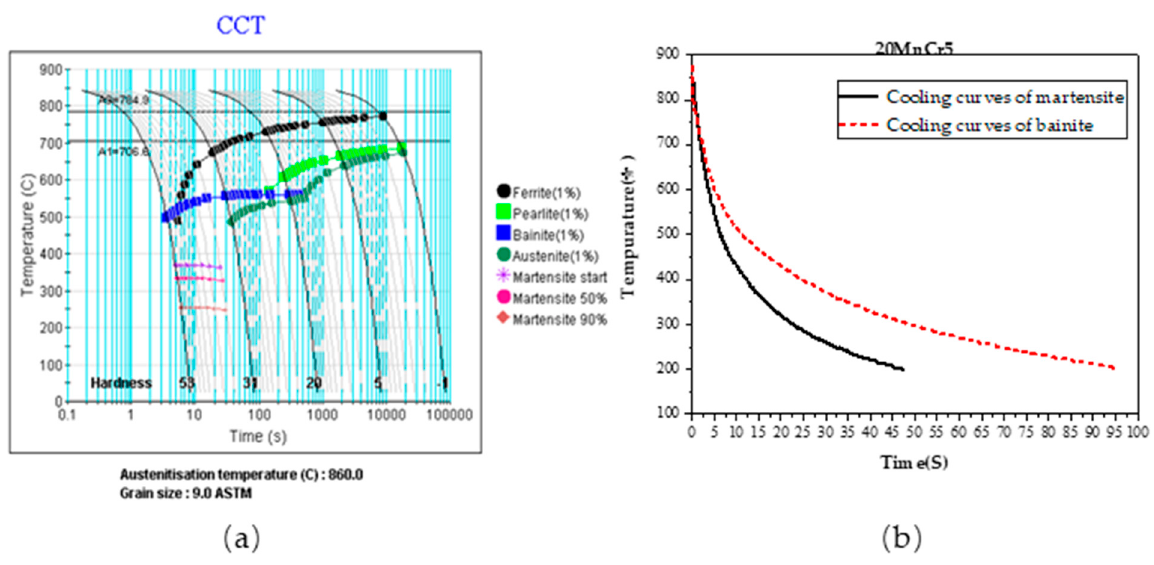
Figure 7. CCT curves and cooling curves of 20MnCr5 steel. ( a ) CCT curves of 20CrMnTiH steel; ( b ) cooling curves of 20MnCr5 steel when martensitic and bainitic transformations can be obtained.